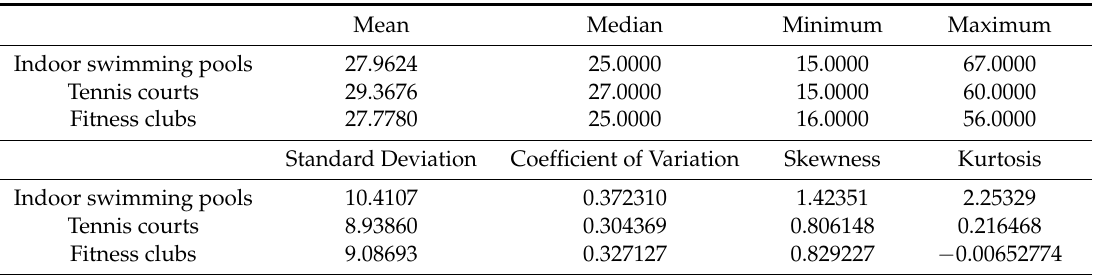
Table 3. Descriptive statistics—for observations from sample N = 1159 for the age variable in each